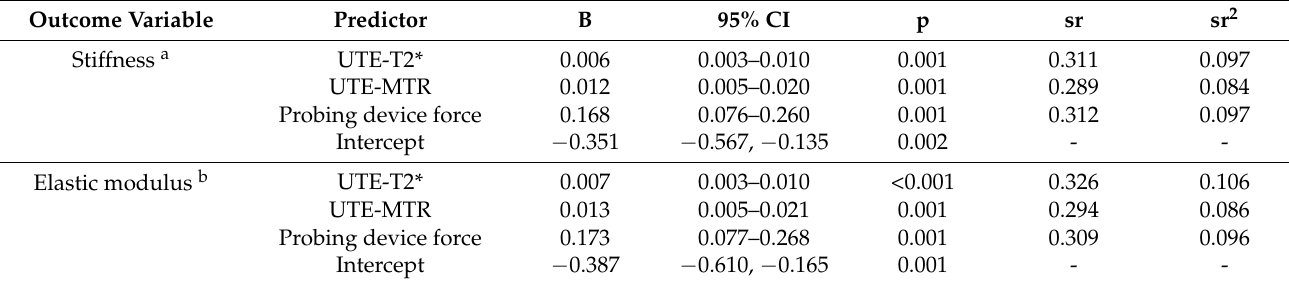
Table 3. Multiple linear regression models on predicting stiffness and elastic modulus. Outcome Variable